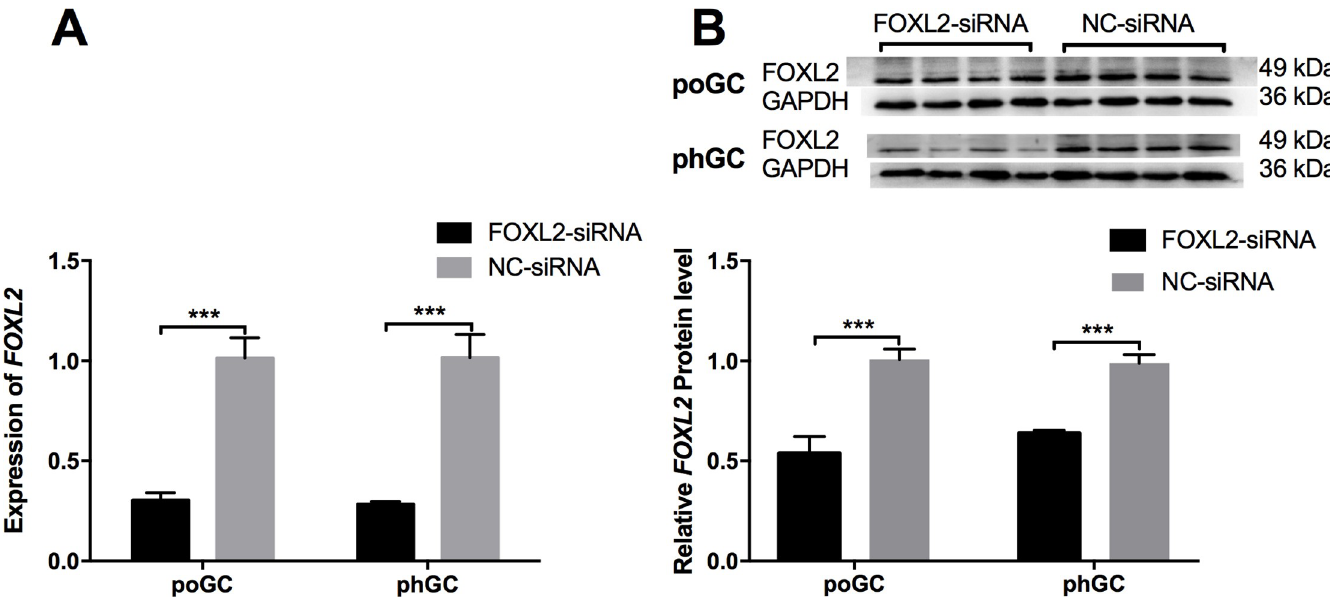
Fig 1. RNA interference of the FOXL2 gene expression in the GCs. (A) poGC and phGC were transfected with FOXL2-siRNA or NC-siRNA, and the expression of the FOXL2 gene was detected by qRT-PCR 48 h post-transfection. (B) poGC and phGC were transfected with FOXL2-siRNA or NC-siRNA, and the expression of the FOXL2 protein was detected by Western blot 48 h post-transfection ( ��� indicates P < 0.001).